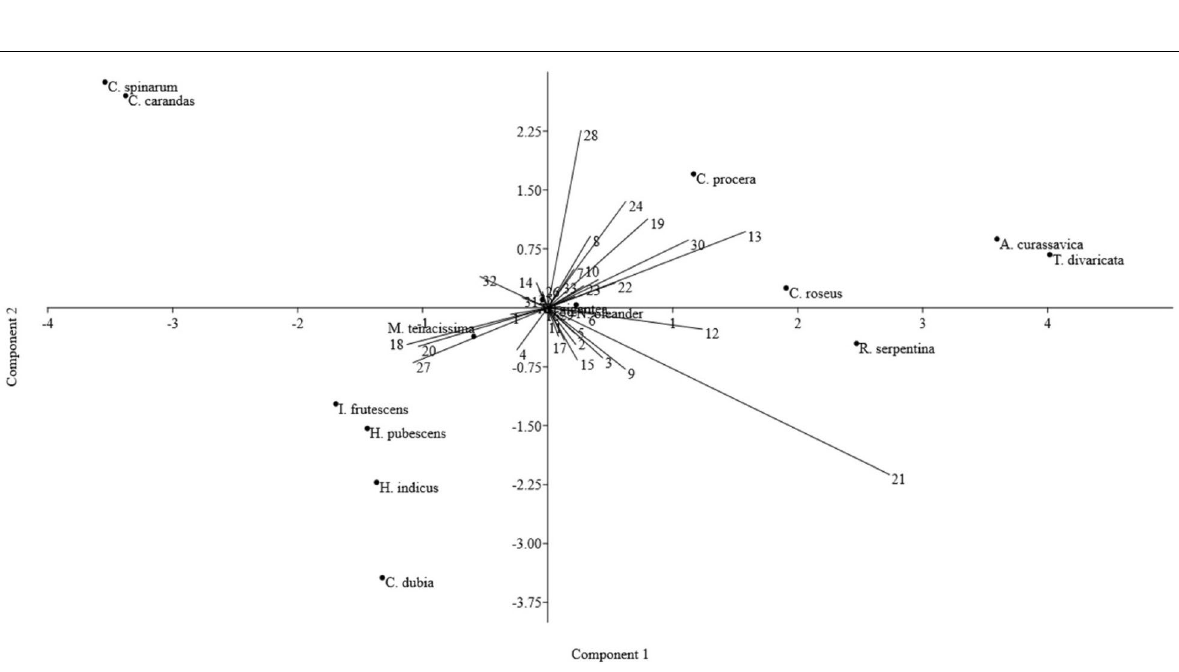
lumen diameter and number of vessels per square as major characters in species